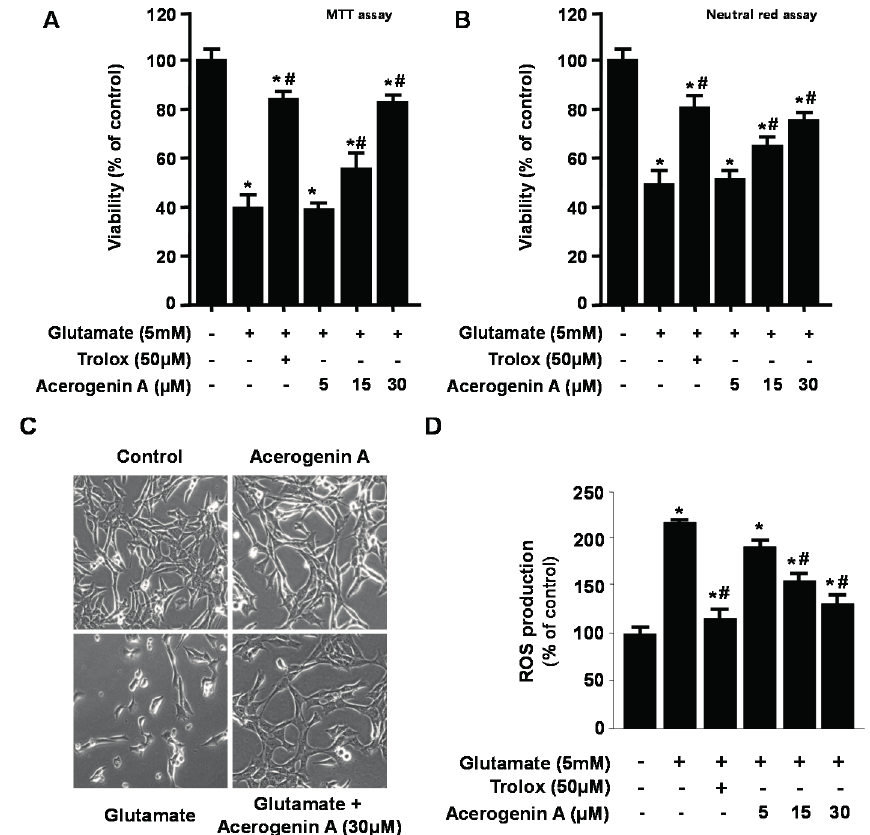
Figure 2. The effects of acerogenin A on glutamate-induced oxidative neurotoxicity ( A – C ) and inhibition of reactive oxygen species (ROS) generation ( D ). HT22 cells were pretreated with the indicated concentrations of acerogenin A for 12 h, and then treated with glutamate (5 mM) for 12 h ( A – C ). Exposure of HT22 cells to glutamate increased ROS production ( D ). Data are presented as mean ± SD values of three independent experiments. Trolox (50 μ M) was used as the positive control. * p < 0.05 vs . control. # p < 0.05 vs .